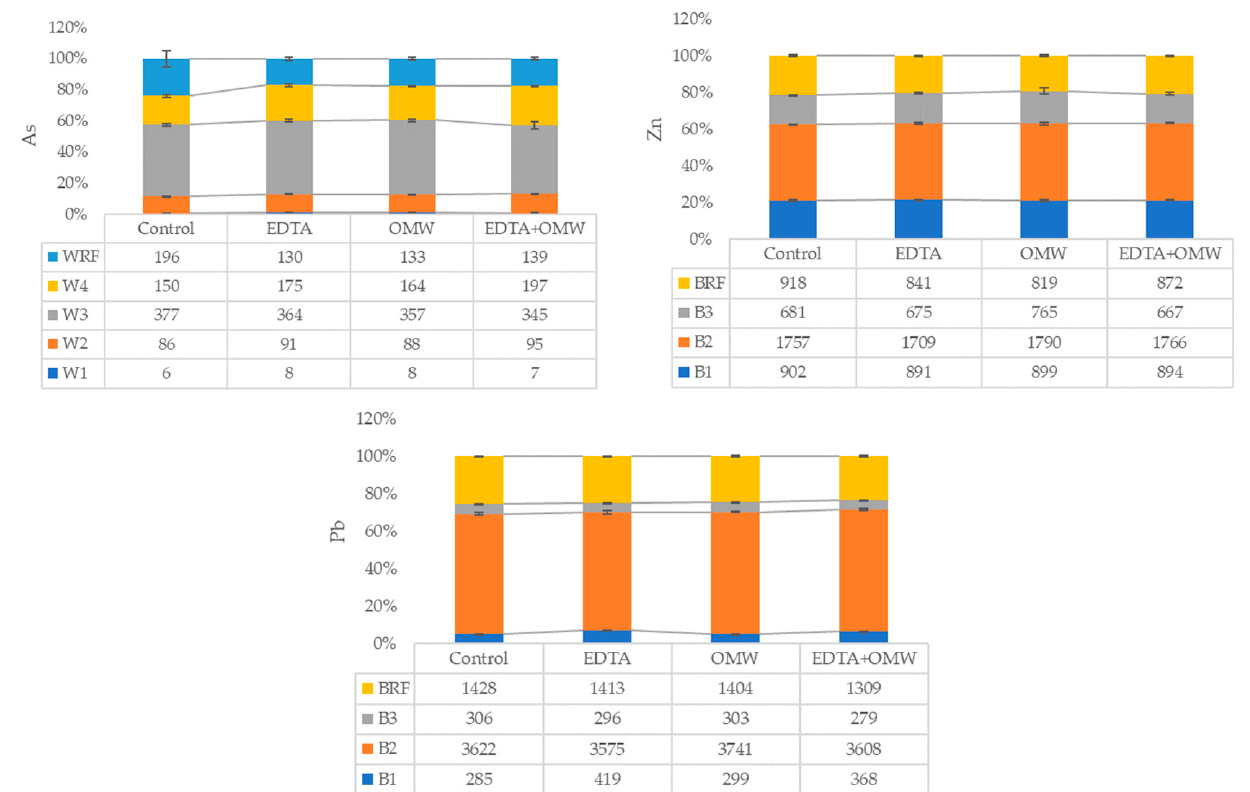
Figure 3. Mean percentages and values of As, Zn and Pb in the different soil fractions, between different treatment schemes (numbers in tables are in mg kg − 1 ). The error bars represent the standard error of the mean at the 95% confidence level ( p ≤ 0.05) ( n = 3). W1: nonspecifically sorbed; W2: specifically sorbed; W3: amorphous hydrous-oxide-bound; W4: crystalline hydrous-oxide-bound; WRF: residual fraction; B1: exchangeable/weak acid soluble; B2: reducible; B3: oxidizable; BRF: residual fraction.